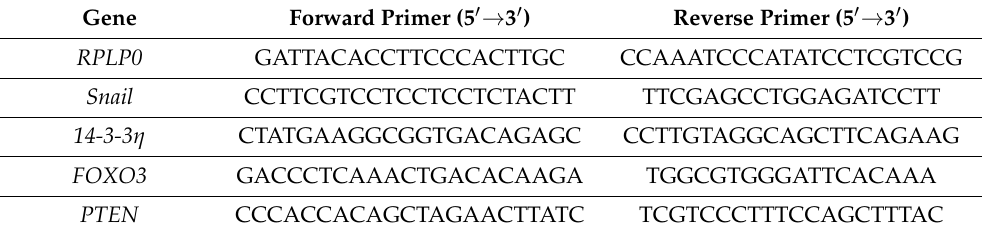
Table 1. qPCR primer